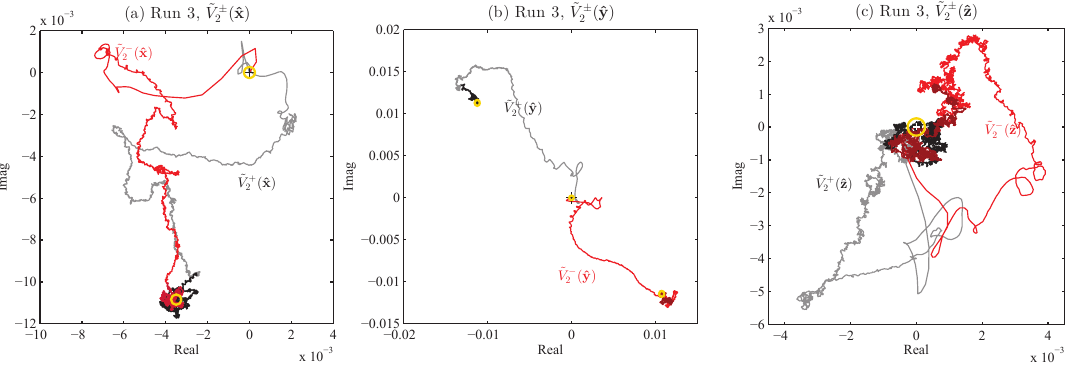
Figure 10. Phase portraits from Run 3; + marks the origin; the variables are normalized by N 3/2 , N = 128. The yellow circles around the origin are the expected average magnitudes; in ( a – c ), these circles have also been placed around the ends of the trajectories, indicating that the fluctuation levels are as predicted, but the mean values are far from zero. Here, ˜ V ± ( ˆ z , t ) [ ˜ b ( ˆ z , t ) ( ˆ z , t )] . ˜ u and ˜ V ± 2 ∼ − ± ±